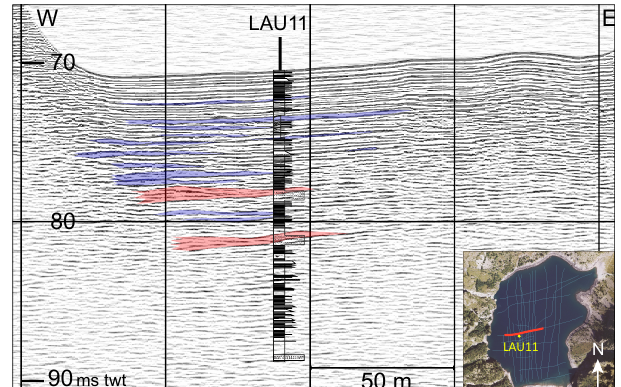
Figure 2. Interpreted seismic profile 03_6 on a W–E direction. LAU11 coring point is indicated by the vertical bar and the sim- plified core results. Red units are interpreted as mass-wasting de- posits and thinner blue layers are interpreted as containing coarse